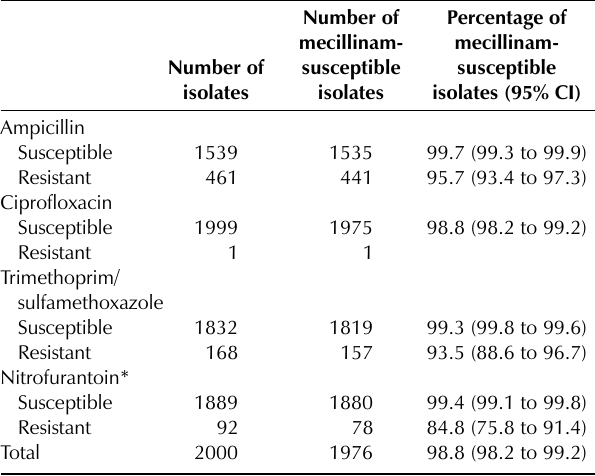
TABLE 3 Activity of mecillinam against antibiotic-susceptible and resistant Gram-negative